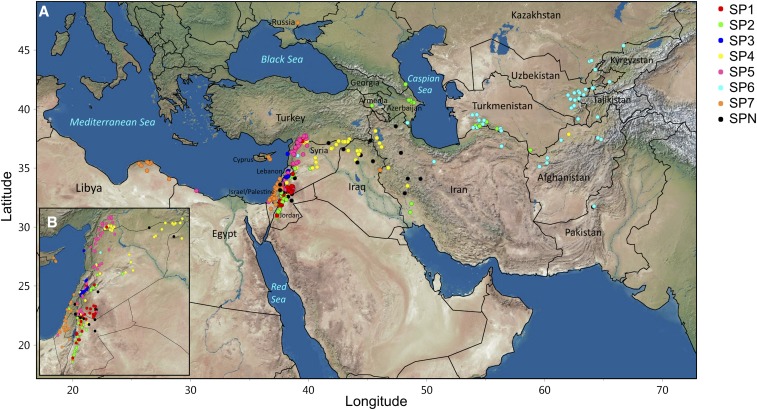
Geographic distribution of accessions in the WBDC and their subpopulation assignment as identified by structure analysis for (A) the entire region and (B) an enlarged insert of the Levant region.